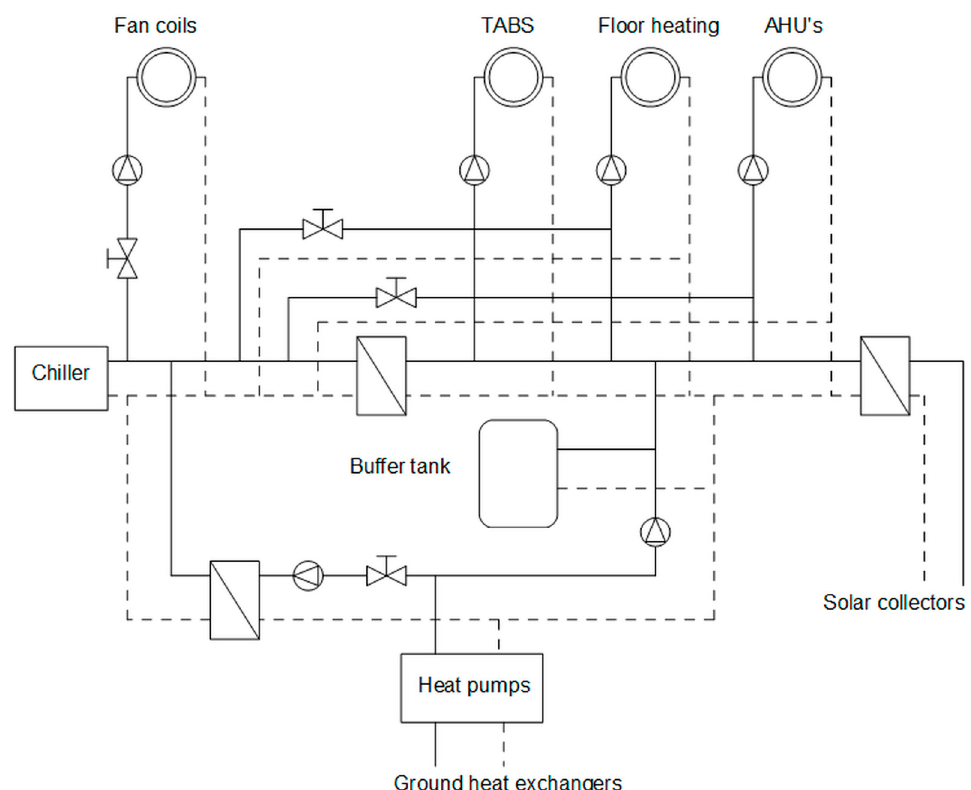
Figure 2. Hydraulic diagram of the heating, ventilation and air conditioning (HVAC) system in the building.